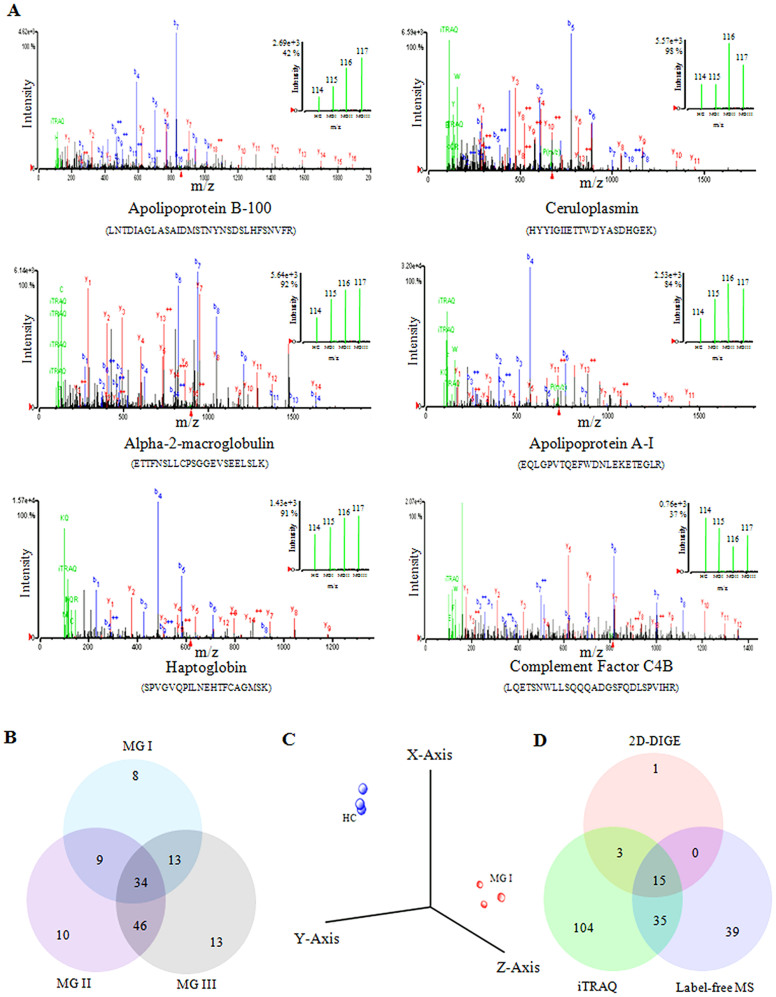
Comparative analysis of different grades of meningiomas by iTRAQ and label-free quantitative proteomics.(A) Representative MS/MS spectrum of a few selected differentially expressed proteins. Inset showing the iTRAQ reporter ion intensities for representative peptides in control and different grades of meningiomas. (B) Venn diagram showing the unique and common differentially expressed proteins in different grades of meningiomas identified in iTRAQ analysis. (C) Discrimination of meningioma grade I patients from healthy controls on the basis of protein expression profile obtained in label-free MS analysis. (D) Venn diagram showing the unique and common differentially expressed proteins in meningiomas identified by 2D-DIGE, iTRAQ and label-free MS.